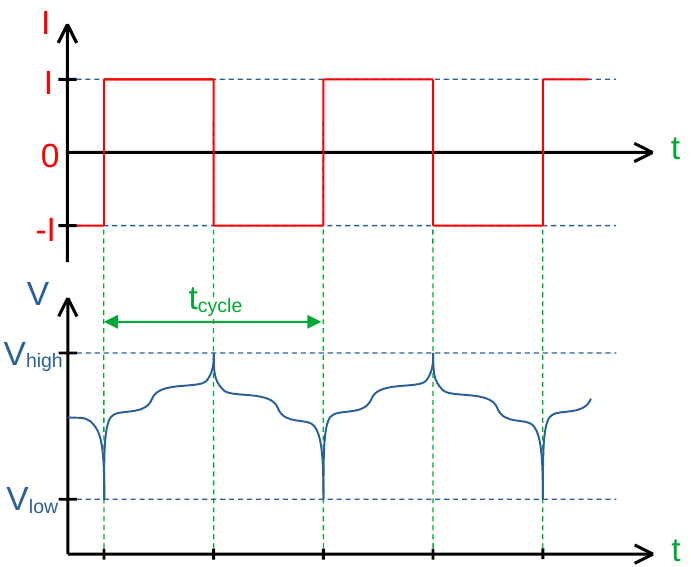
Figure 8. Operating the cell with the C/x-scheme means that it is charged with a constant current between the lower and upper terminal voltage. t cycle stands for the approximate duration of a charging or discharging process (the exact time varies with decreasing cell capacity because the cycling current stays